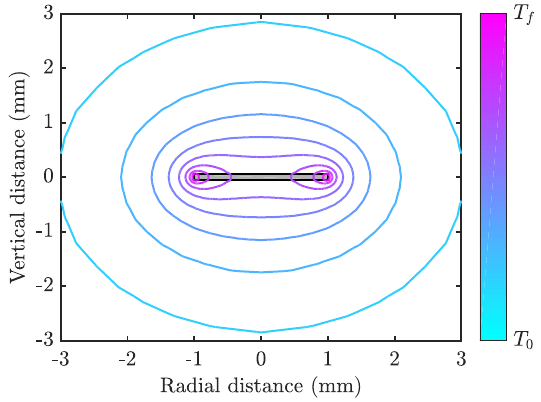
Figure 1. Example of temperature distribution around a disk-shaped crystal (filled grey region outlined in black) of radius 1mm and thickness 0.1mm. Contours of temperature are shown varying be- tween the freezing temperature T f and the far-field temperature T 0 < T f . In this example the crystal is growing into freshwater, and the thermal conductivity of ice is 4 times larger than than of water. The numerical calculations used to make this figure are described in Rees Jones and Wells (2015).